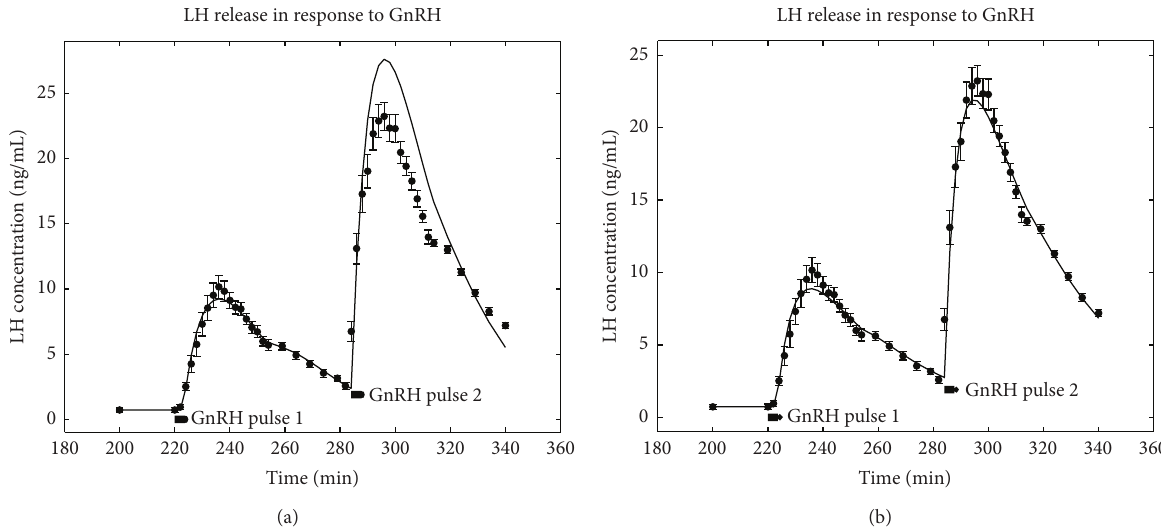
Figure 3: The optimal solution to the interaction model, (10), which results in an augmented response to the second stimulating pulse of GnRH. (a) Optimal solution to the first GnRH pulse with a prediction for the priming effect of the second stimulating pulse of GnRH. (b) In contrast showing what the model can achieve with an optimal solution to both GnRH